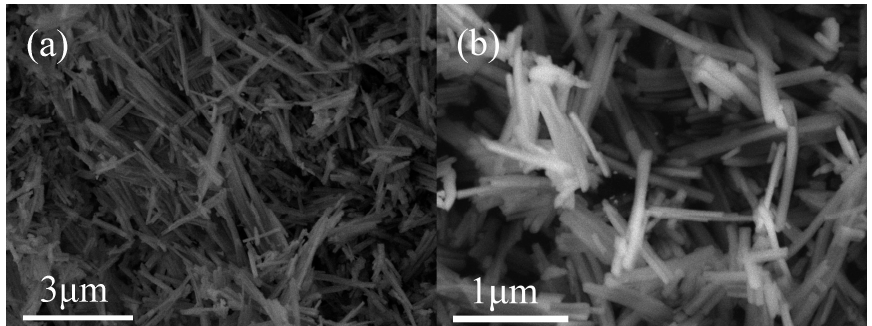
Figure 2. The SEM images of catalysts: ( a ) MOF–BTC and ( b ) Pt/MOF–BTC. With the presence of Pt, the size for MOF–808 or UiO–66 was smaller and the surfaces of catalysts became rougher (shown in Figure S2b,d). This result indicated the etching effect of reducing agent. However, for Pt/MOF–BTC, the etching effect was not obvious according to SEM images (Figure 2b). The morphology of Pt/MOF–BTC was kept with the loading of Pt. This could be due to other characteristics, such as pore volume, which will be discussed